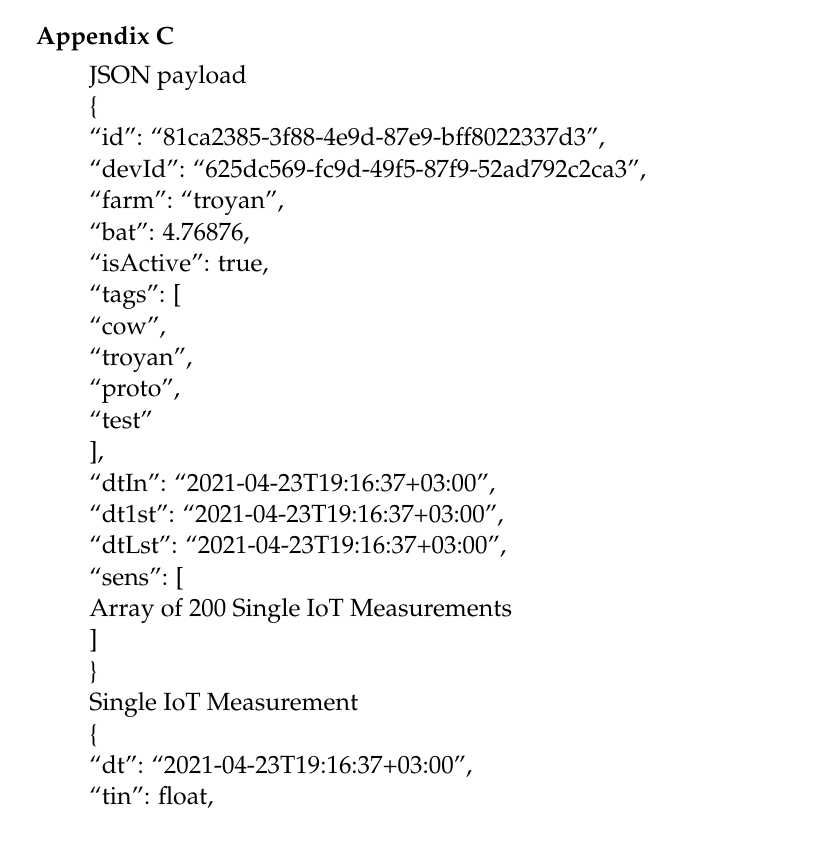
Figure A2. Amazon Kinesis Data Generator